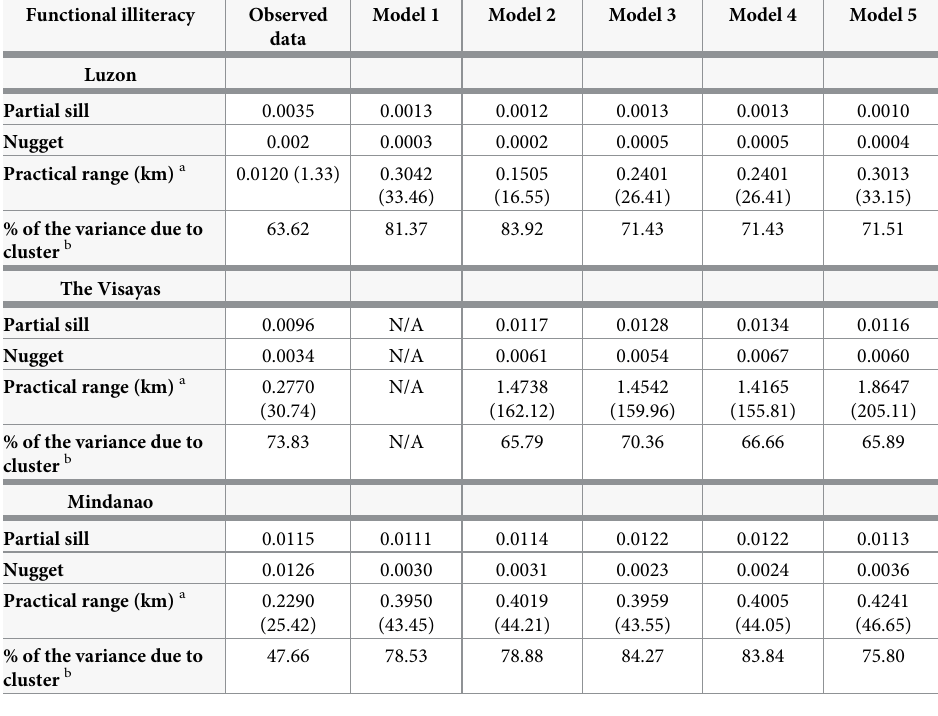
Table 8. Results of semivariograms for prevalence of functional